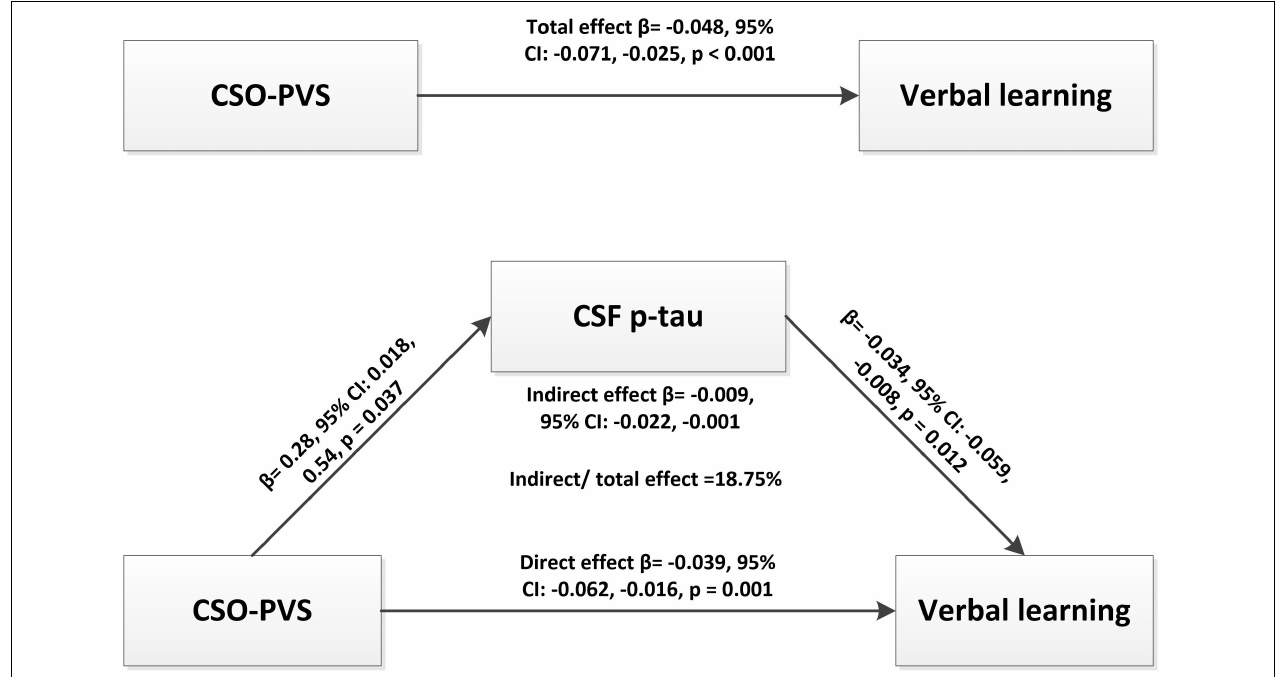
FIGURE 3 | Mediation analysis revealed that CSF p-tau had a significant indirect effect ( β = -0.009, 95% CI: -0.022 -0.001, p = 0.001) and mediated 18.75% effect for the relationship between CSO-PVS and verbal memory in traumatic brain injury (TBI) group after adjusting for age, education, apo e4, CMBs, and